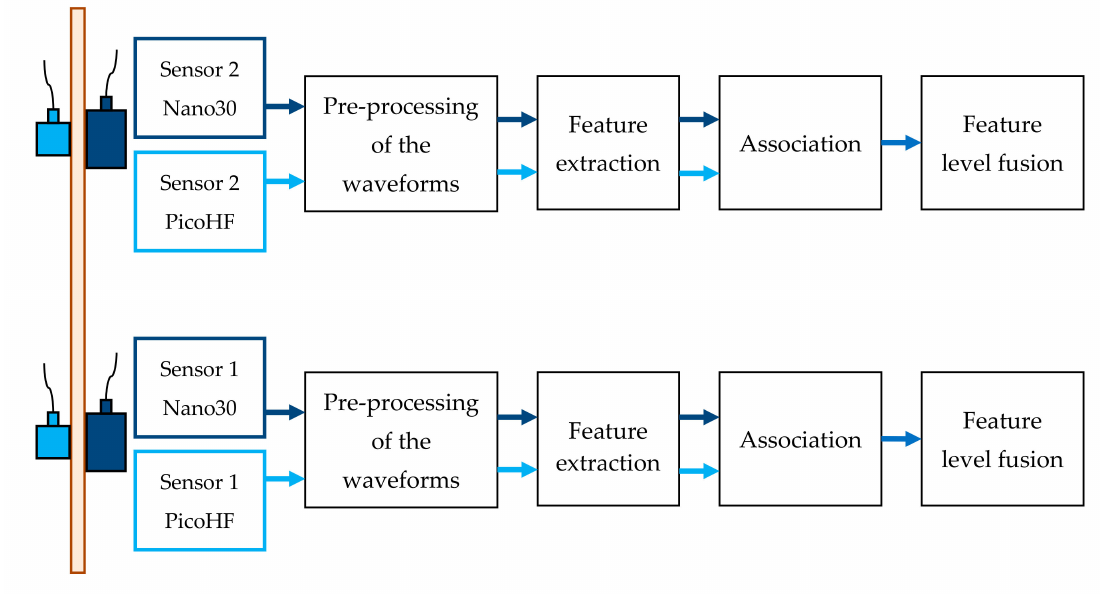
Figure 6. Processing flowchart for features-based signal